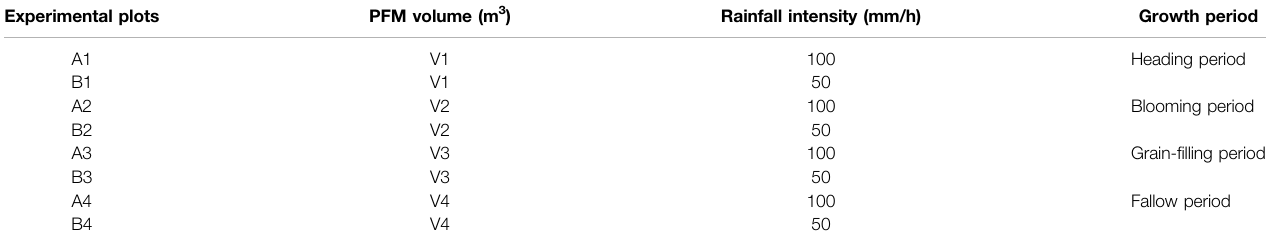
TABLE 1 | Scenarios designed and their corresponding experimental plots.